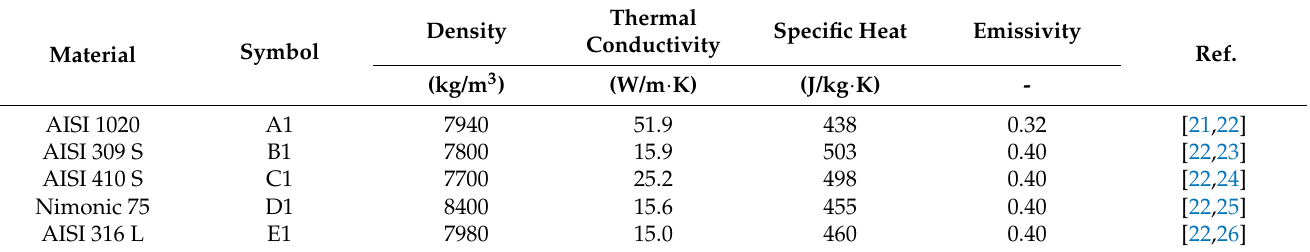
Table 1. Thermophysical properties of the selected metallic materials.